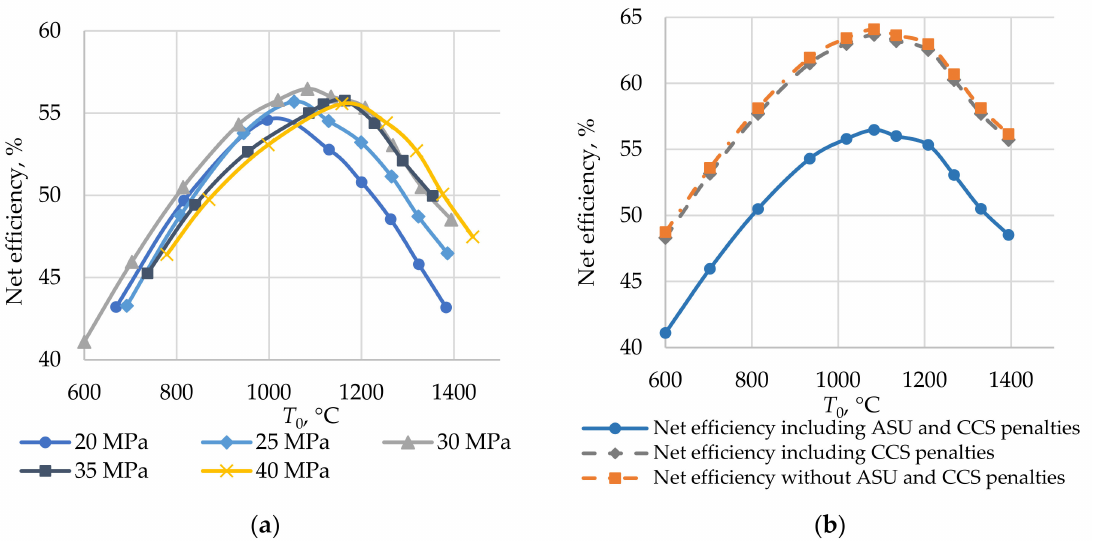
Figure 13. The Allam cycle parameters optimization, cooling losses included: ( a ) net efficiency vs. initial parameters; ( b ) net efficiency relation to losses for O 2 production and CO 2 storage.